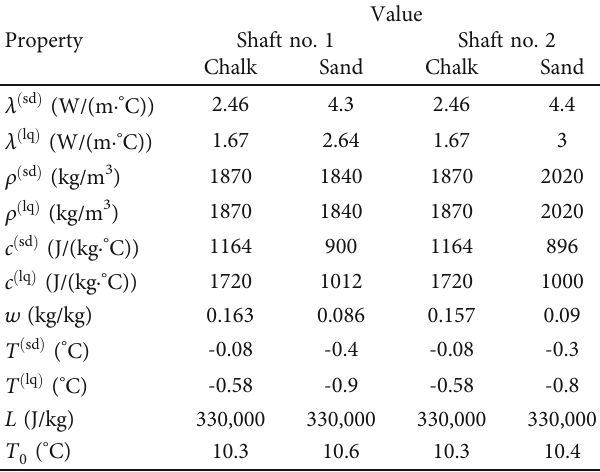
Table 1: Thermal properties of studied soil layers.